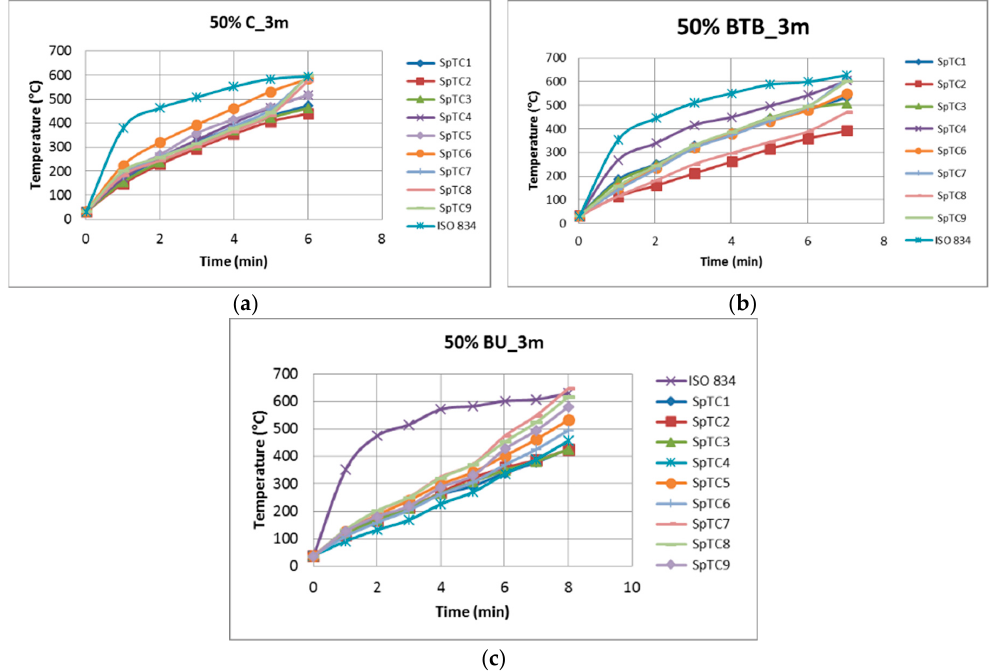
Figure 7. Typical surface temperature along the ( a ) channel; ( b ) back-to-back; ( c ) box-up column.